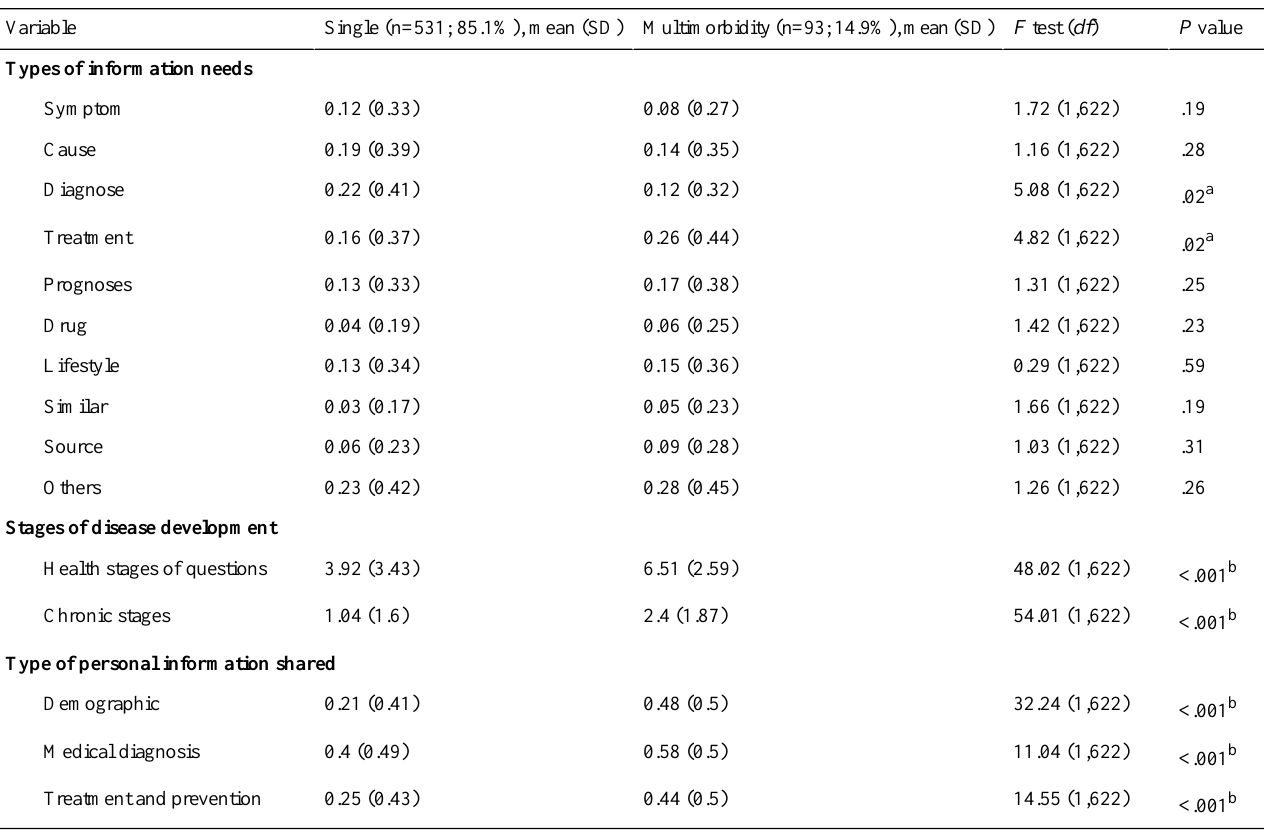
Table 1. Descriptive statistics of the data sets and analysis of variance results of disease